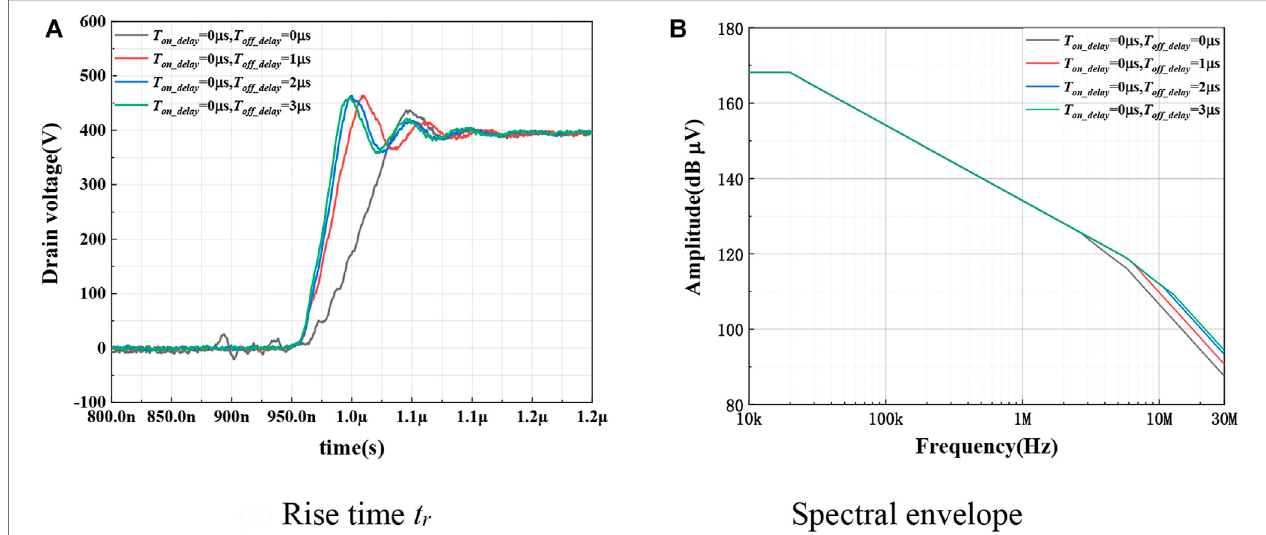
FIGURE 11 | Waveforms of CM voltage and its spectral envelope at different T off_delay (pattern 4). (A) Rise time tr and (B) spectral envelope.